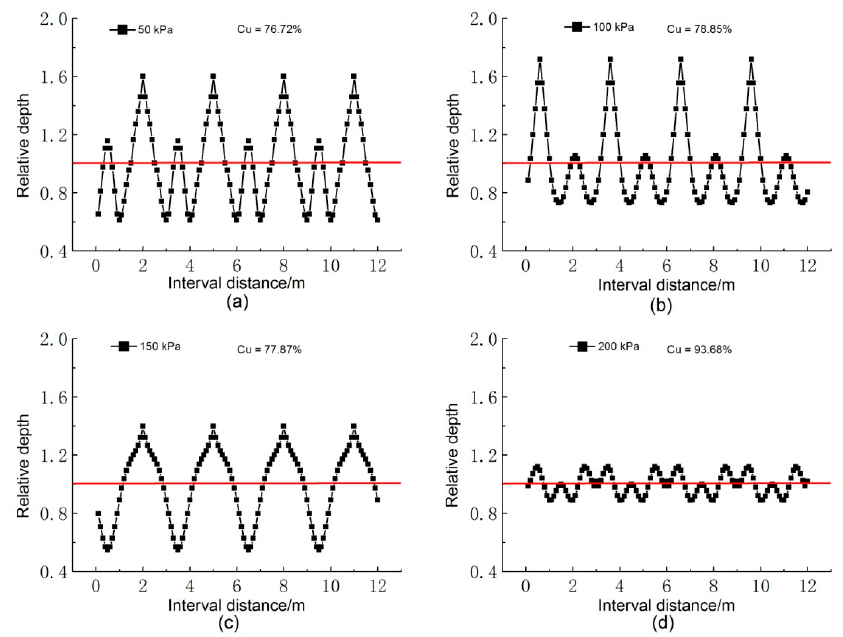
Figure 13. Calculated relative water depths for the Nelson D3000 FSPS with a 2 m sprinkler mounting height, 3 m sprinkler spacing, and different working pressures: ( a ) 50 kPa, ( b ) 100 kPa, ( c ) 150 kPa, and ( d ) 200 kPa.